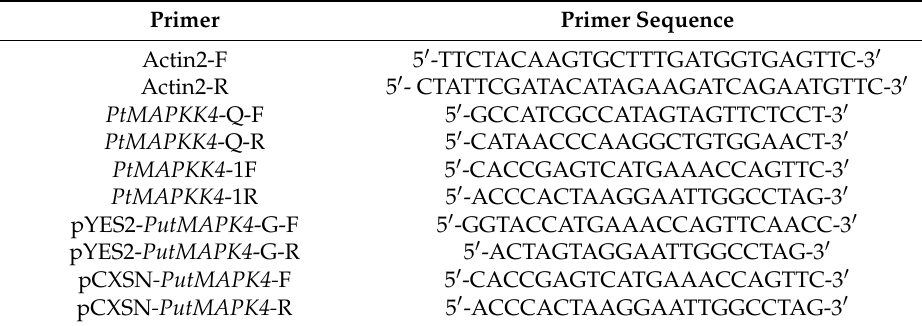
Table 1. Primers used for quantitative RT-PCR (qRT-PCR) and gene